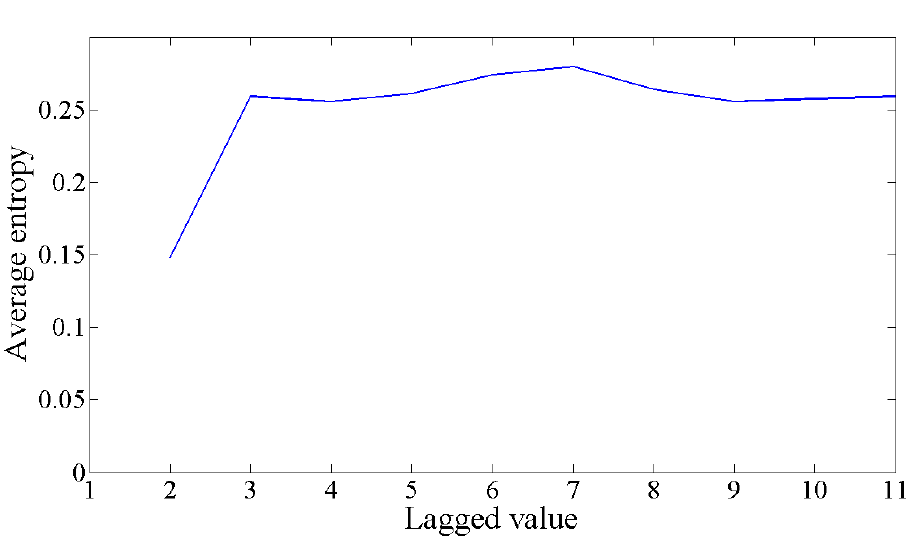
Figure 3. The study’s data set for gold prices.